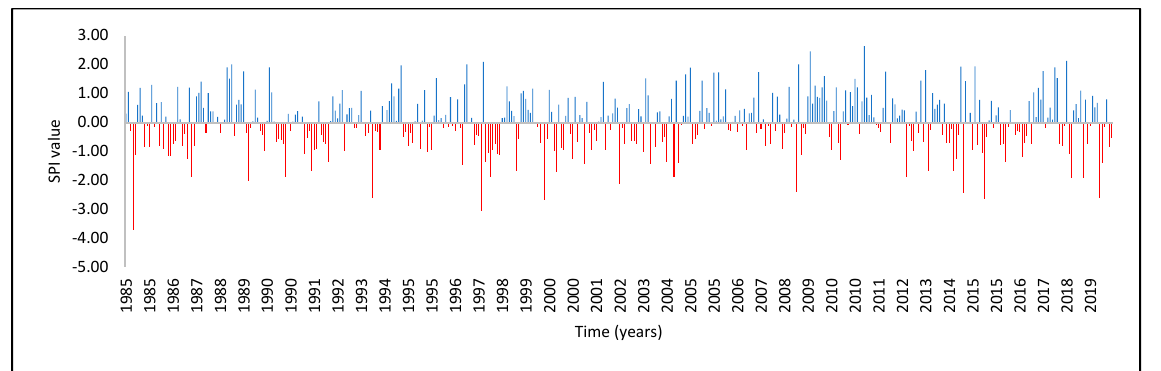
Figure 6. SPI time series, Unisucre station in the period (1985–2019).